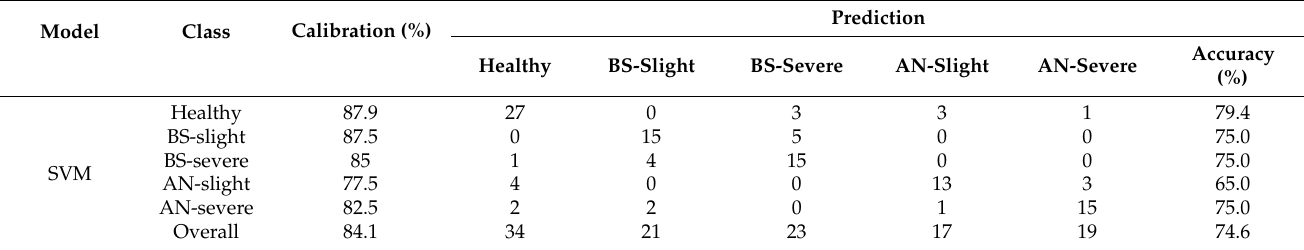
Table 6. Classification results of different degrees (slight and severe) and diseases (brown spot and anthrax) in cucumbers based on SVM and XGBoost algorithms